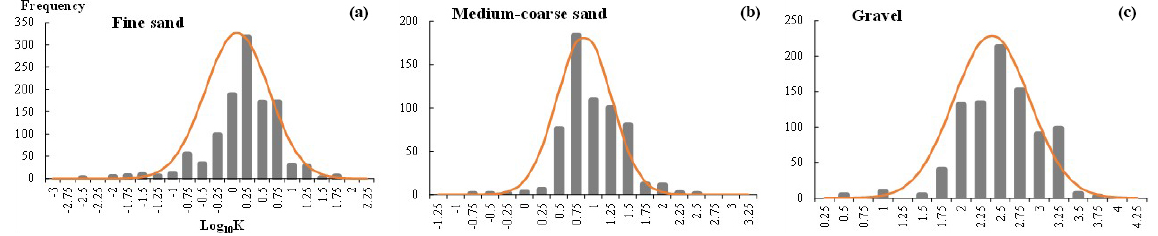
Figure 5. Histograms of log 10 K for fine sand, medium-coarse sand and